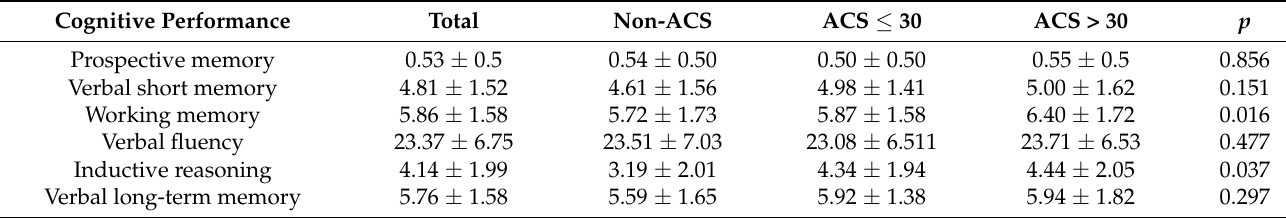
Table 3. Difference in dimension of cognitive performance by categories of